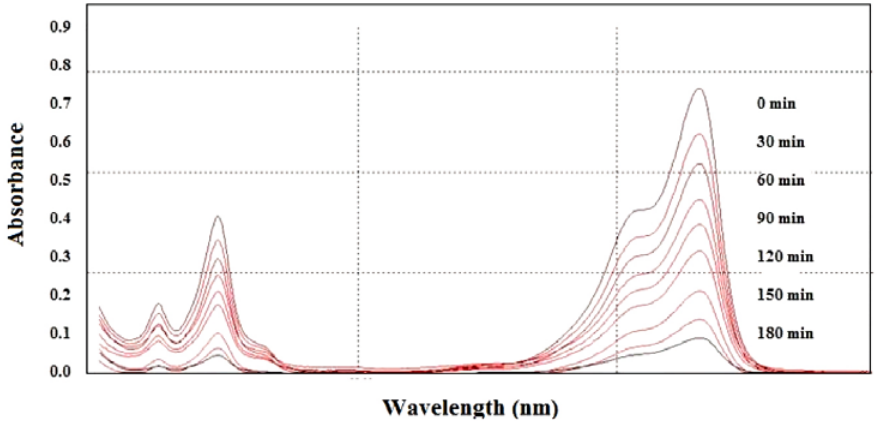
Figure 5a. Absorption spectra of the MB solution (C = 0.075 M and l = 1 cm) taken at different photocatalytic degradation times using Ni- Fe O –NG. 2 4